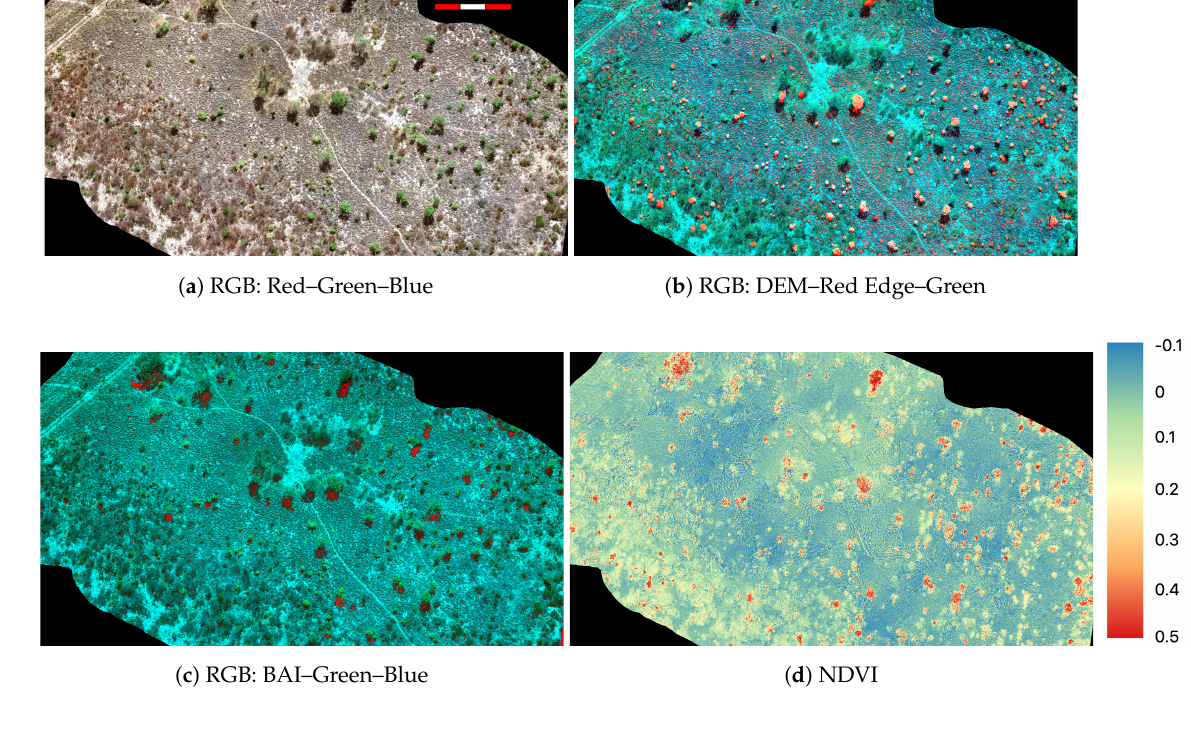
Figure 6. (False-)Colour composites ( a – c ) and a single-band pseudo-colour image ( d ) from an orthophoto of an example plot in Tsodilo Hills, Botswana: ( a ) regular RGB image; ( b ) canopy height; ( c ) shadows; and ( d ) vegetation greenness. The total area of the plot displayed here is approximately 2.8 ha.